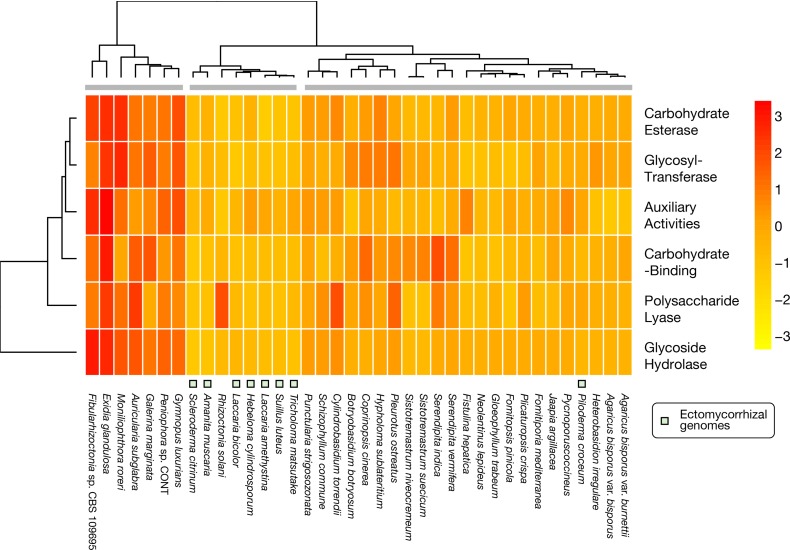
CAZyme genes in Tricholoma matsutake and 37 Agaricomycetes.All available CAZyme modules were counted. Scaled values based on row Z-scores were used to fill each cell.